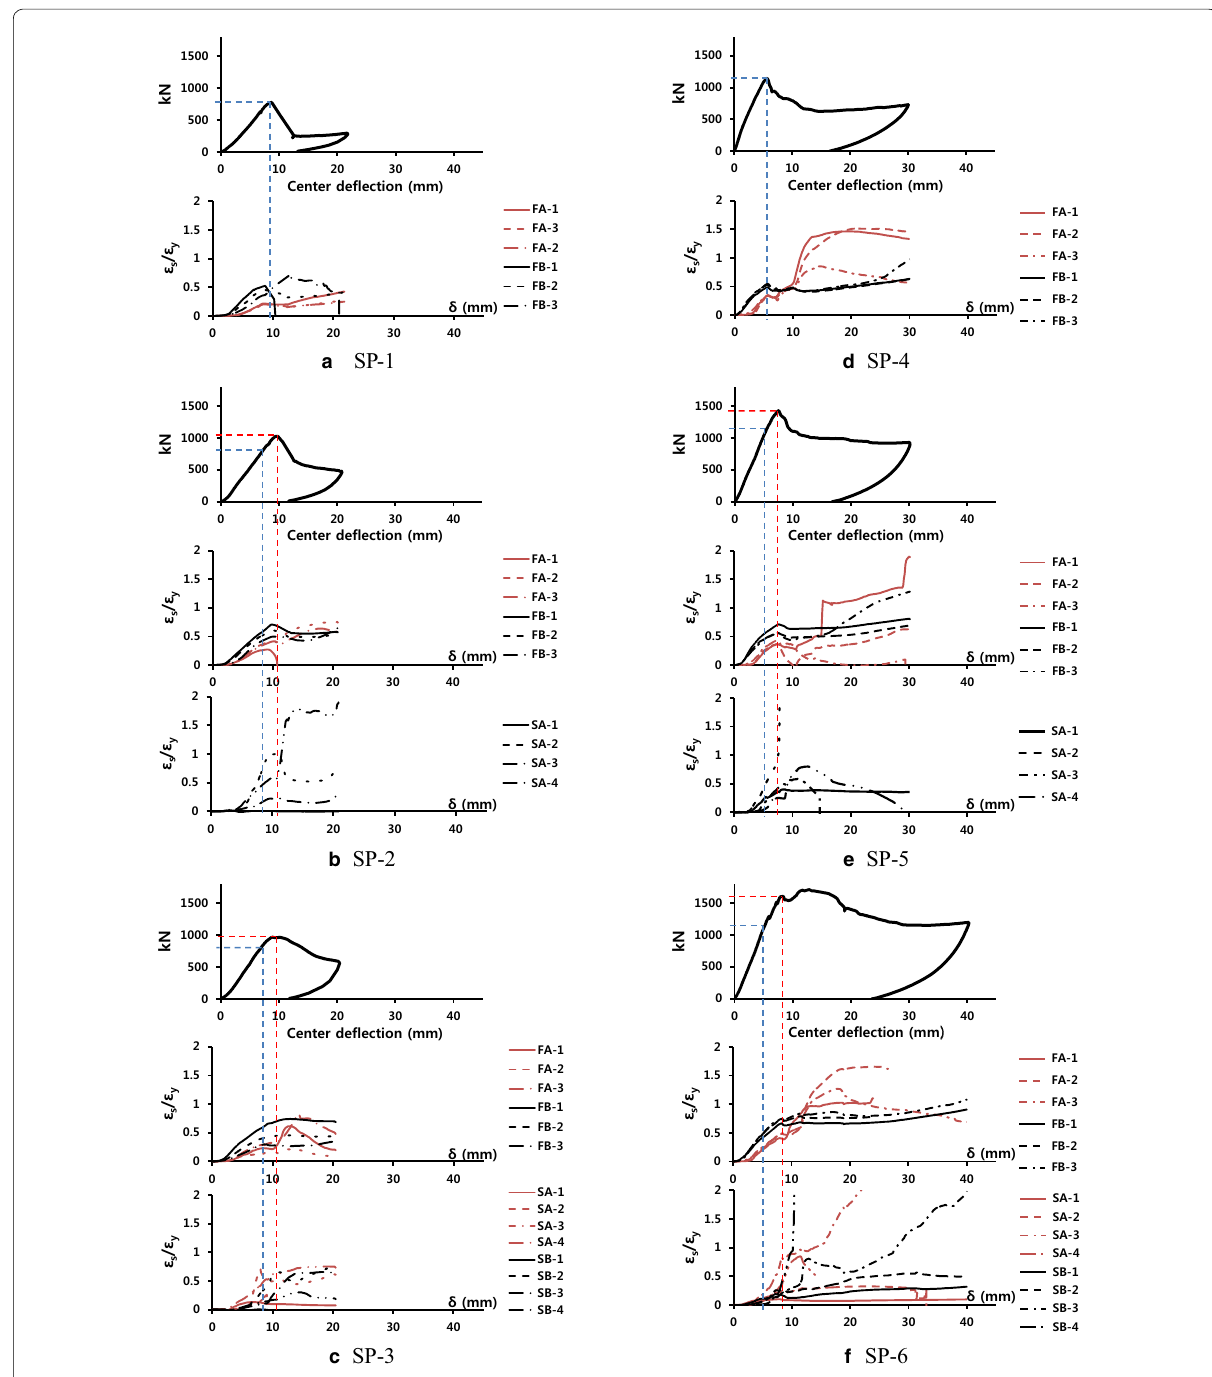
c SP-3 f SP-6 Fig. 7 Strains of flexural and shear